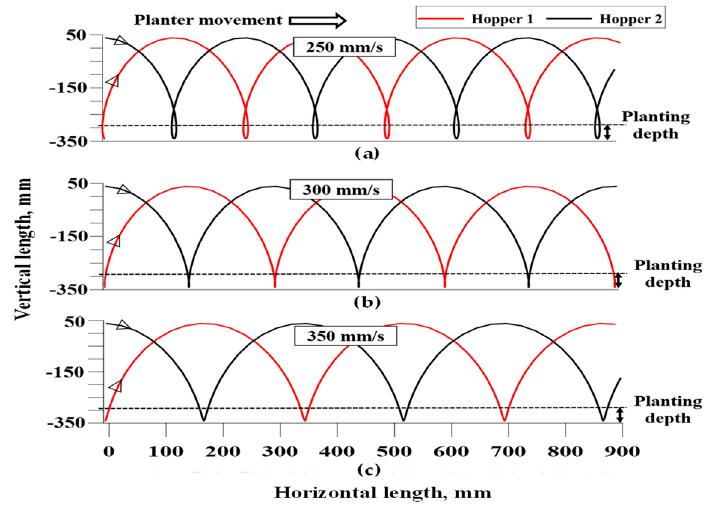
Figure 8. Trajectory of dibbling hopper for forward speeds of 250 ( a ), 300 ( b ), and 350 mm/s ( c ). A tangent point on the working trajectory of the dibbling mechanism was able to indicate the direction for the ultimate speed of seedling movement. For the transplanter forward speed of 350 mm/s, 0 < λ < 1 was yielded in the working trajectory of the dibbling mechanism, where a portion of the working trajectory under the soil surface generated a very short cycloid (Figure 8). The direction of the horizontal speed at every point of the short cycloid was the same as the direction of the forward speed of the